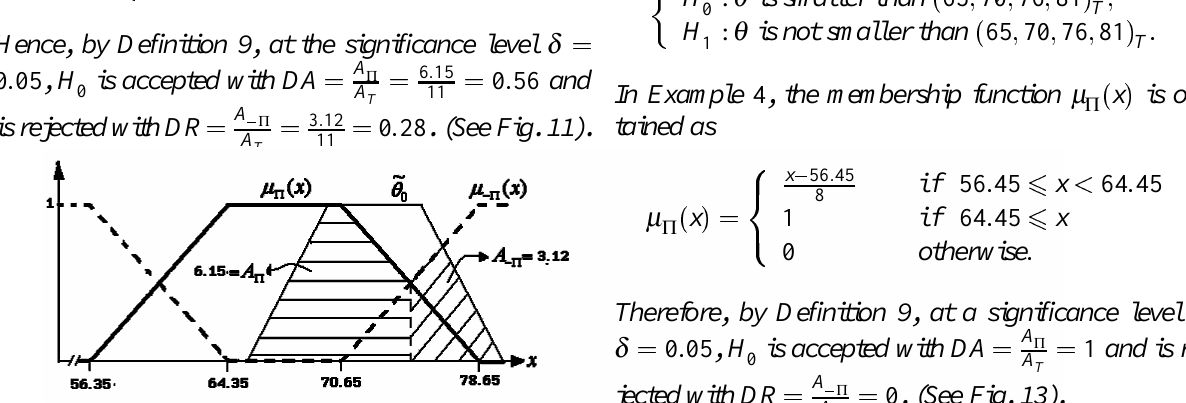
is accepted (rejected) with DA 0